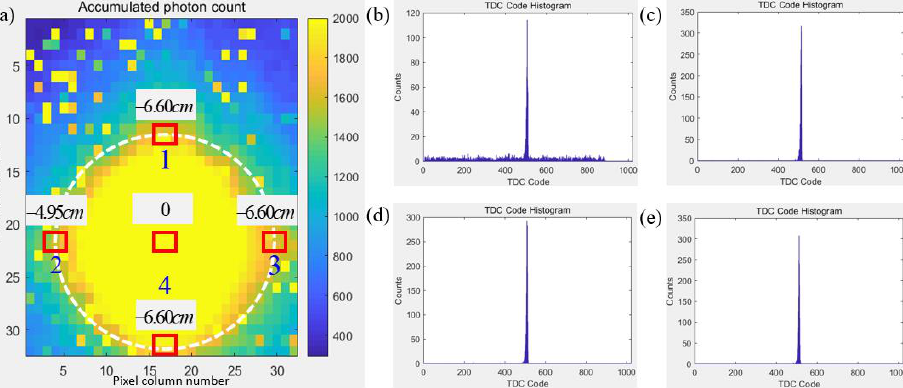
Figure 5. ( a ) Schematic diagram of the deviation of the measured distance at different positions of the light spot. ( b – e ) TCSPC distribution reflecting the distance information of the typical location of the spot boundary. 4. Results 4.1. Lidar Performance Index To explore the performance index of the lidar, we performed the following experi- ments to obtain the lidar ’ s depth precision and ranging accuracy corresponding to one collecting port. This is a necessary step before the experiment to obtain the spatial position